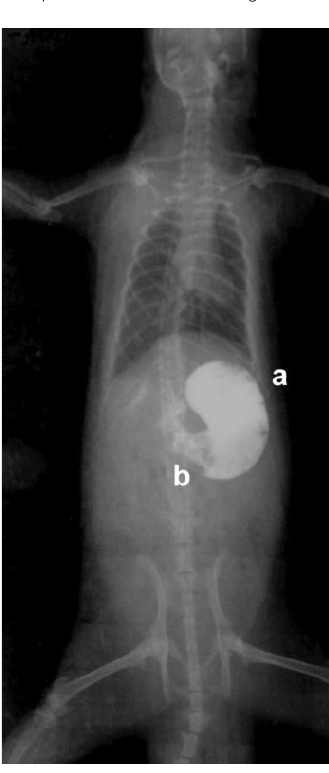
Figure 5. Contrast facial radiographs of a tacrine-treated rat immediately after administration of CM. CM is present only in the stomach. (a) shows an enlarged view of the fornical part. The antral area (b) is contracted. Some peristaltic waves are